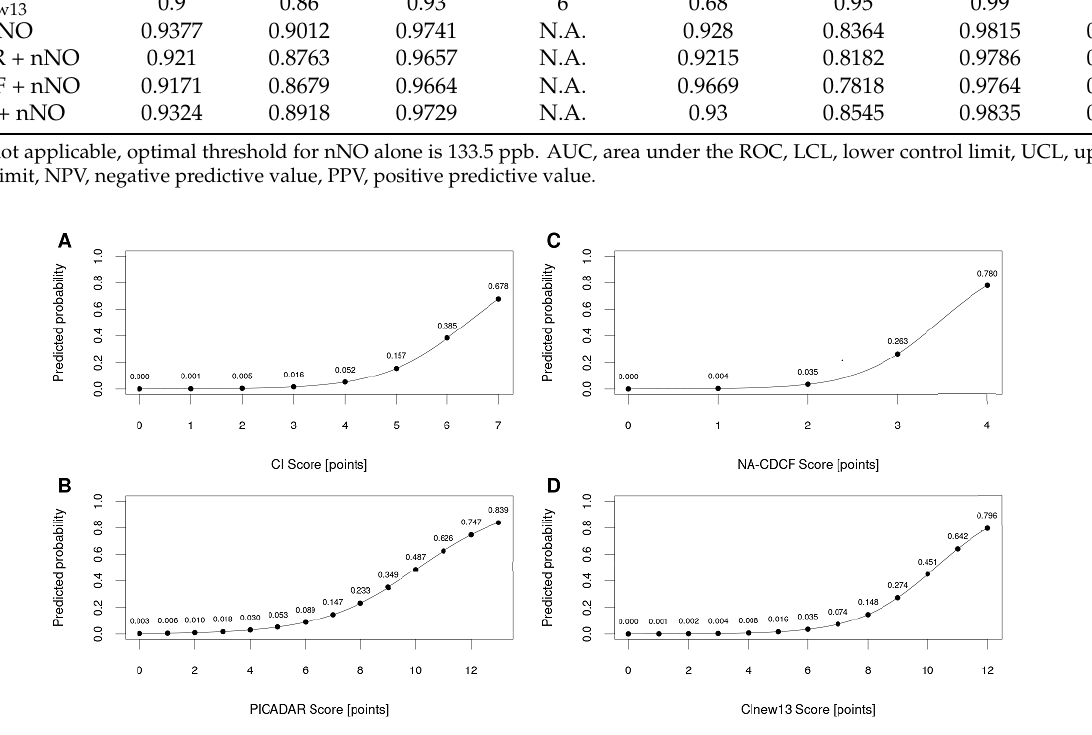
Figure 4. Probability curves for the respective tools—CI ( A ), PICADAR ( B ), NA-CDCF ( C ), and CI new13 ( D ).